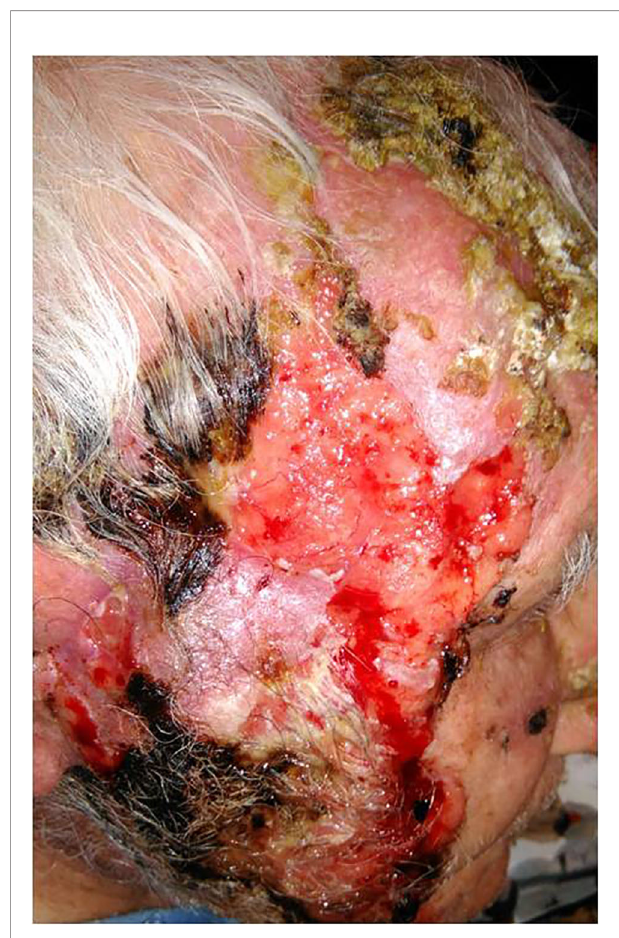
FIGURE 1 | Locally advanced locally cutaneous squamous cell carcinoma of the face extending to the zygomatic area close to the lower eyelid, the right cheek and the mandibular area, characterized by necrotic ulcerated areas and in fi ltration of subcutaneous